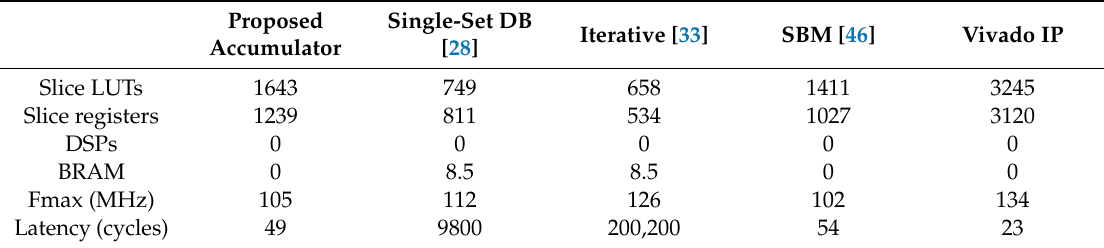
Table 4. Post implementation accumulator resource usage, maximum frequency, and latency on Xilinx Artix 7